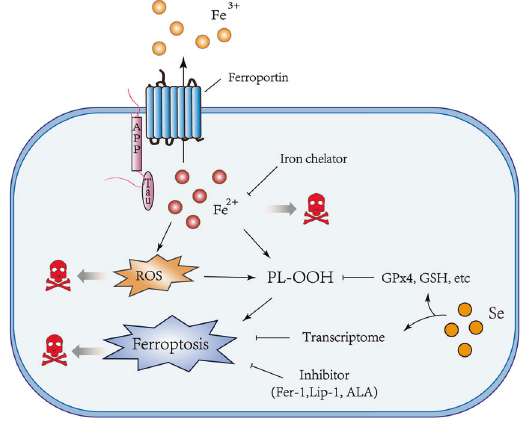
Fig. 4 Iron, ROS, ferroptosis, and ischemia-reperfusion injury. The relationships between iron, ROS, and ferroptosis in